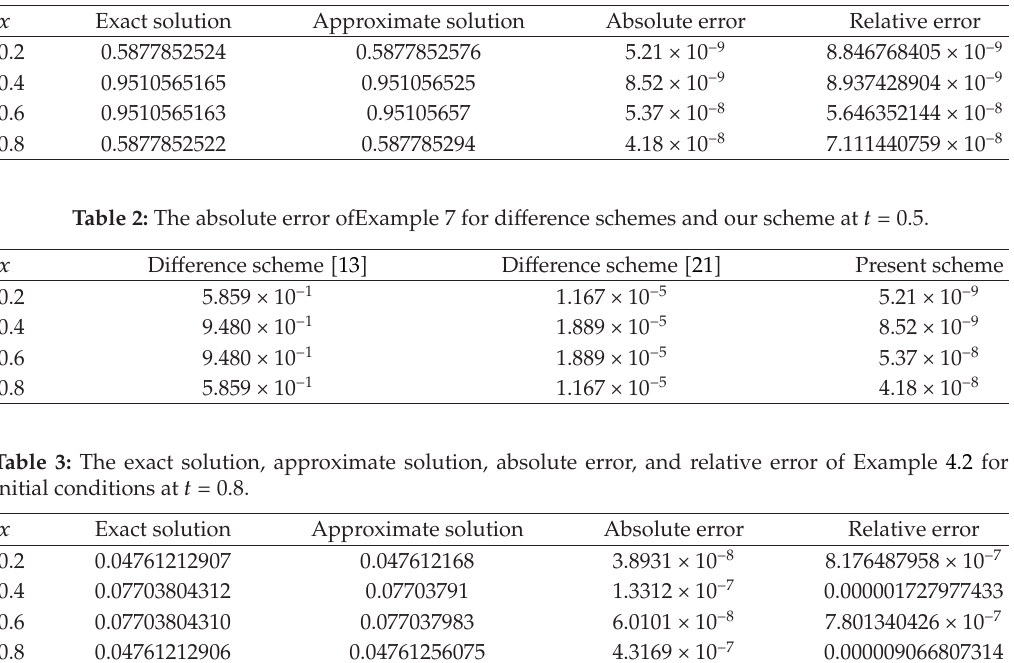
Table 1: The exact solution, approximate solution, absolute error, and relative error of Example 4.1 for initial conditions at t (cid:3) 0 . 5.